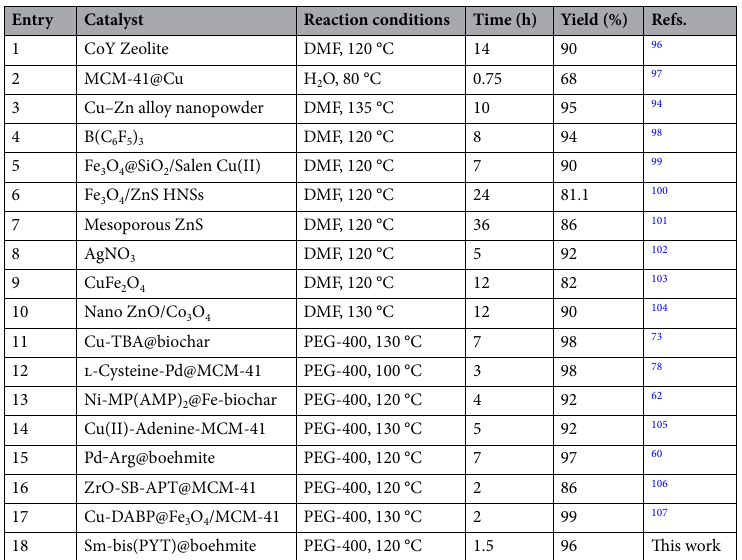
Table 6. Comparison results of Sm-bis(PYT)@boehmite with other catalysts for the synthesis of 5-phenyl-1 H - tetrazole.